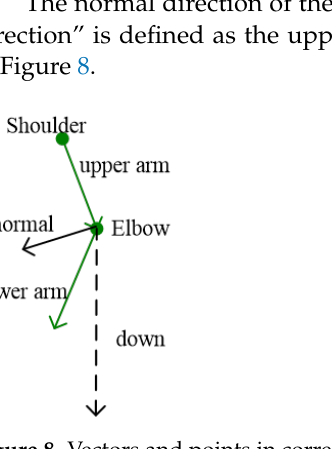
Figure 8. Vectors and points in correction algorithm for arms.